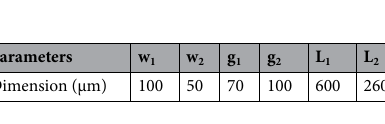
Table 1. Unit cell geometry dimension for 250